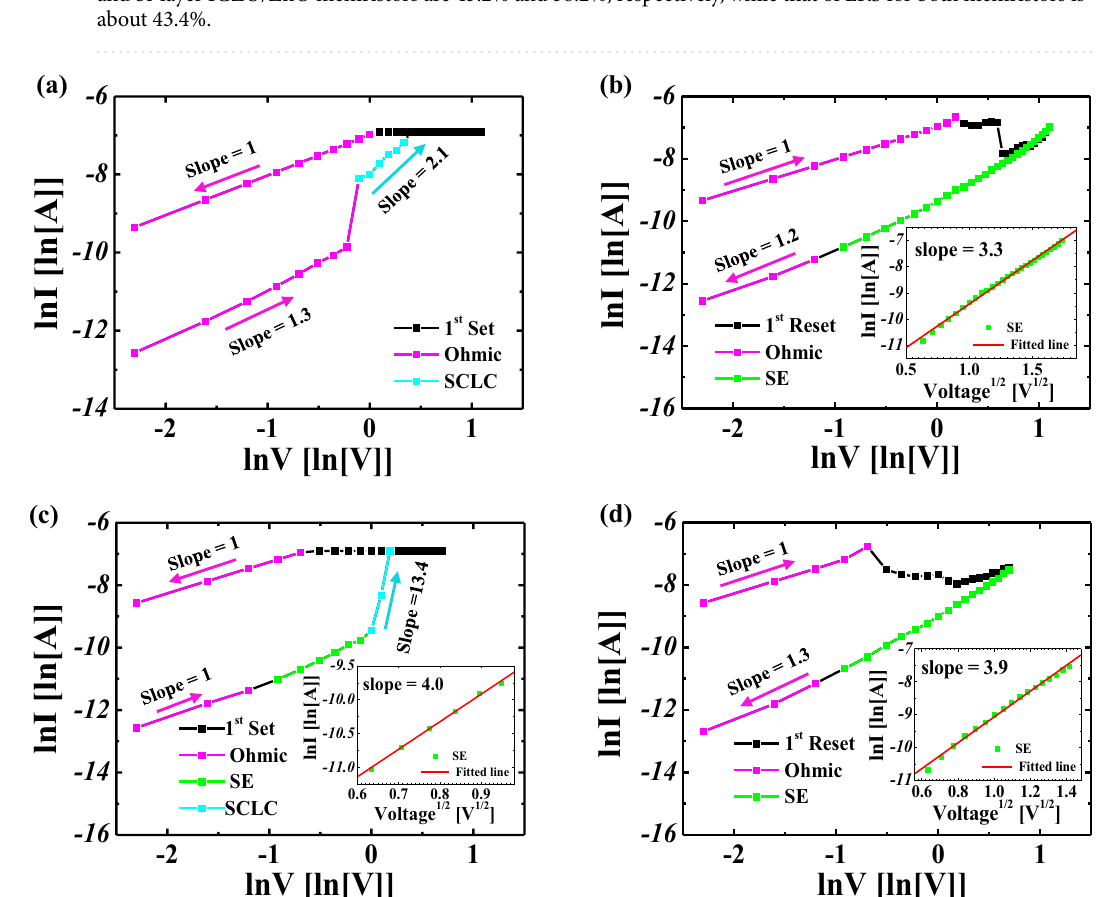
Figure 6. Analysis of the conduction mechanism corresponding to SET and RESET ( a ), ( b ) a single IGZO memristor and ( c ), ( d ) bi-layer IGZO/ZnO memristor, respectively. Schottky emission mechanism is observed in the single IGZO and bi-layer IGZO/ZnO memristors at the RESET, which can be attributed to the interface